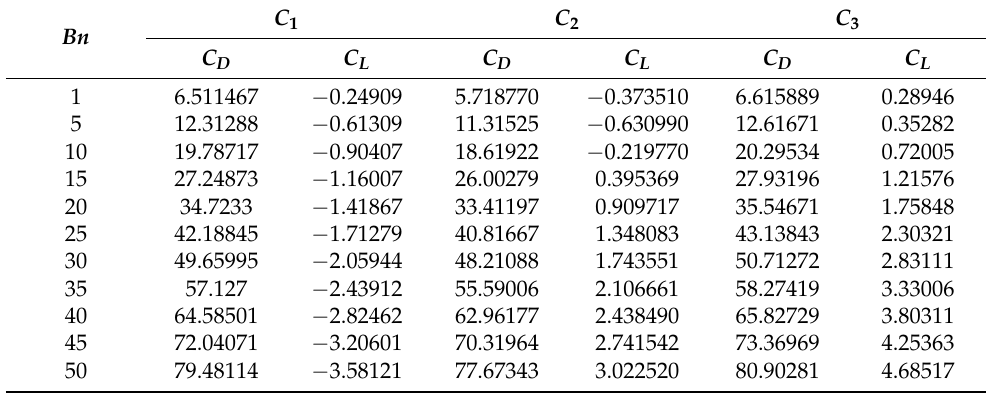
Table 3. Drag and Lift Coefficients for Various Bn with Different Centre of